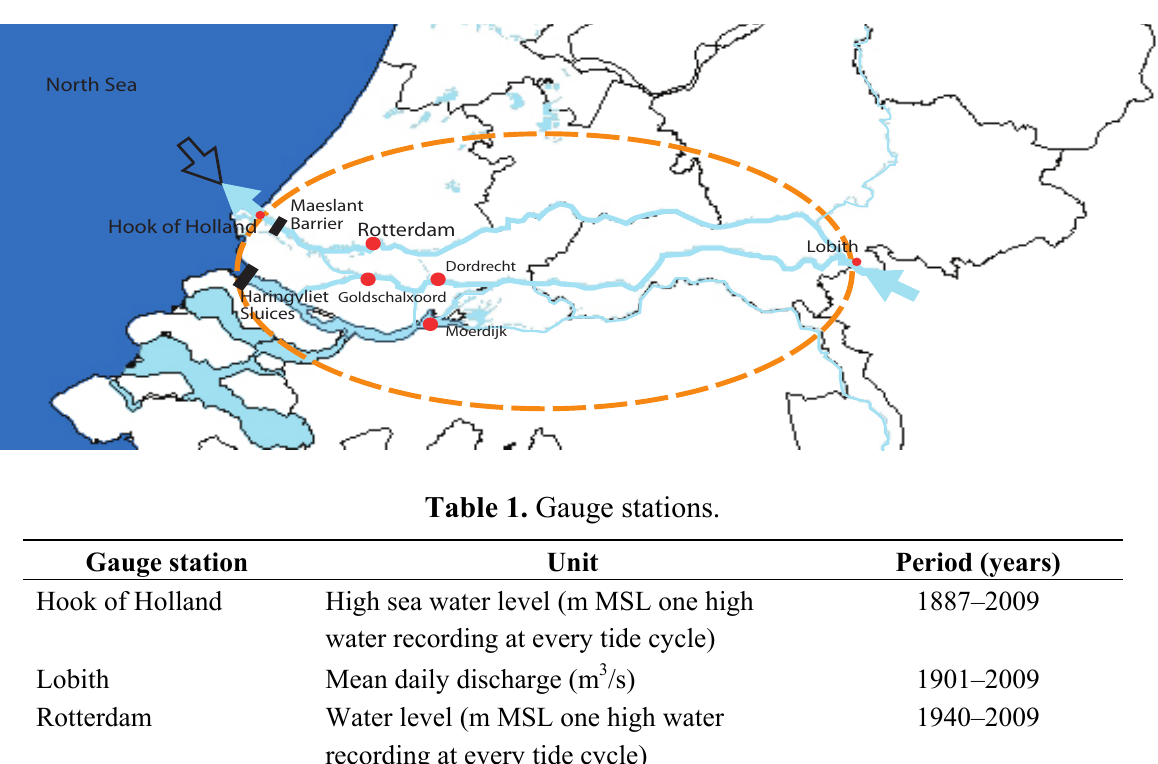
Figure 1. The Rhine-Meuse Delta in the Netherlands.